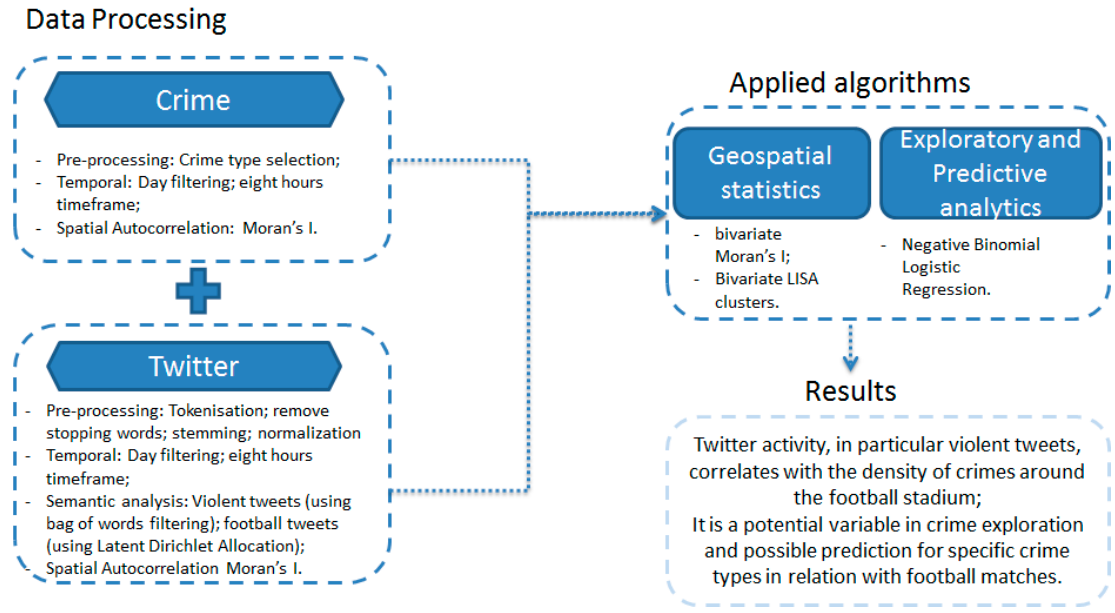
Figure 2. Analysis framework.